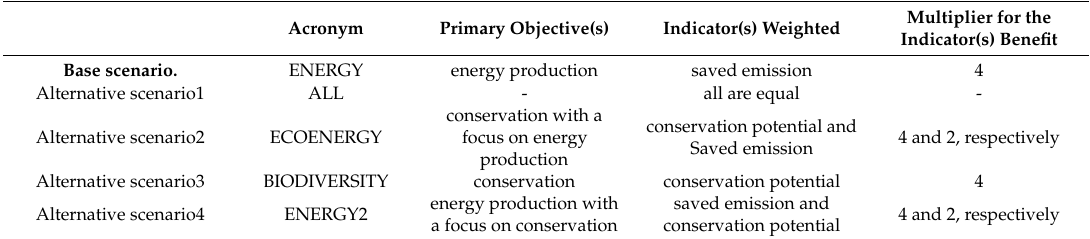
Table 2. Base and alternative scenarios and the applied weights to ecosystem service indicators.